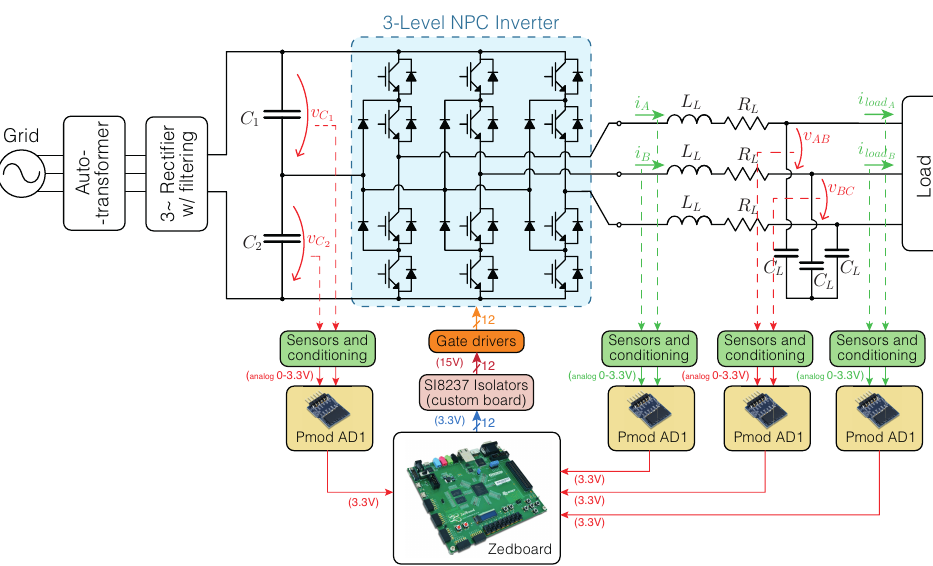
Figure 28. Schematic representation of the experimental setup used for UPS inverter control.